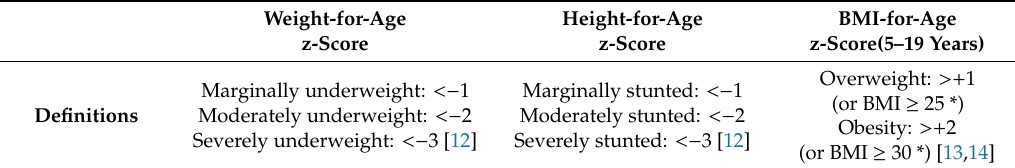
Table 1. Definitions to characterise weight-for-age, height-for-age and BMI-for-age in patients with citrin